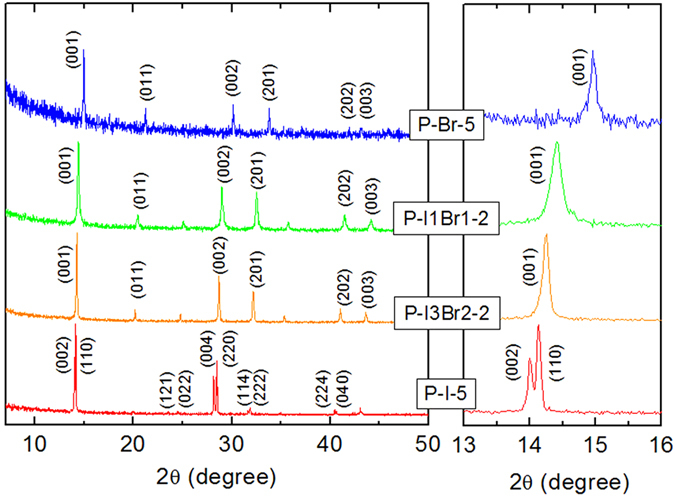
The XRD patterns of some typical as synthesized MAPbBrxI3−x(0 ≤ x ≤ 3) nanocrystals: sample P-I-5, P-I3Br2-2, P-I1Br1-2 and P-Br-5.